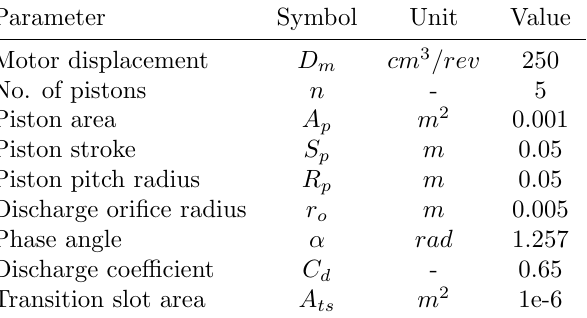
Table 5: Axial piston motor parameters